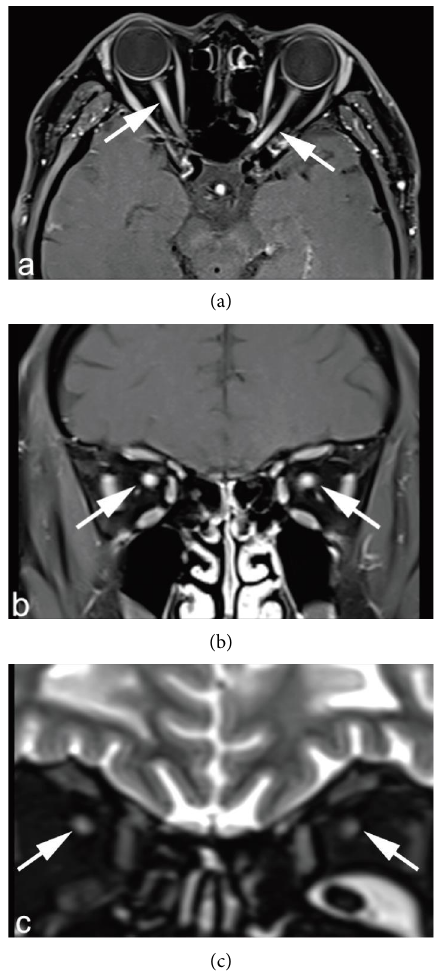
Figure 1: MRI identifed optic nerve lesions in patients with methanol-induced optic neuropathy. Axial (a) and coronal (b) T1 enhancement images of patient 4, demonstrating hyperintense signals (arrows) in both optic nerves; (c) coronal T2 image of patient 8, demonstrating hyperintense signals (arrows) in both optic nerves.